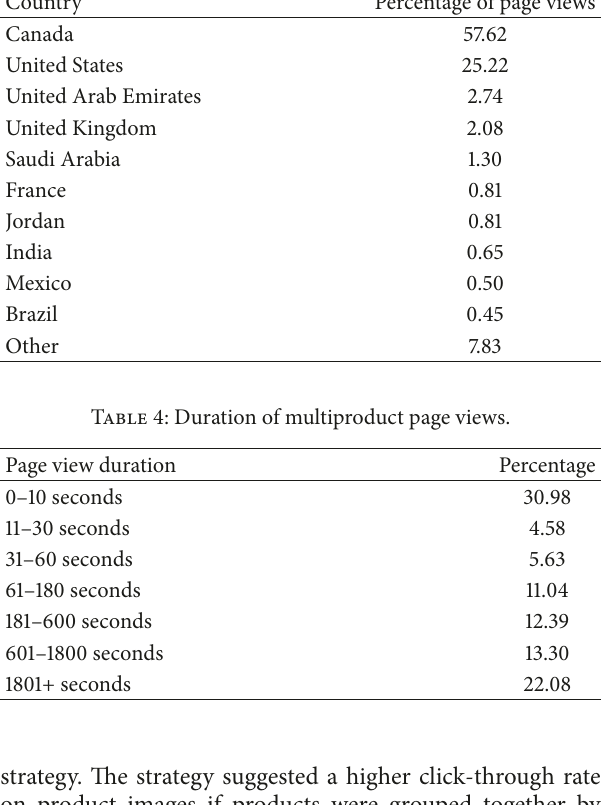
Table 3: Geography of consumers in study. Country